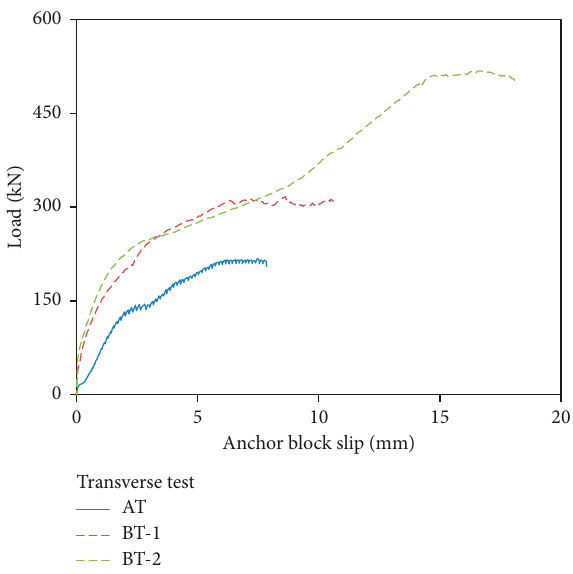
Figure 14: Transverse load-anchor block slip response.